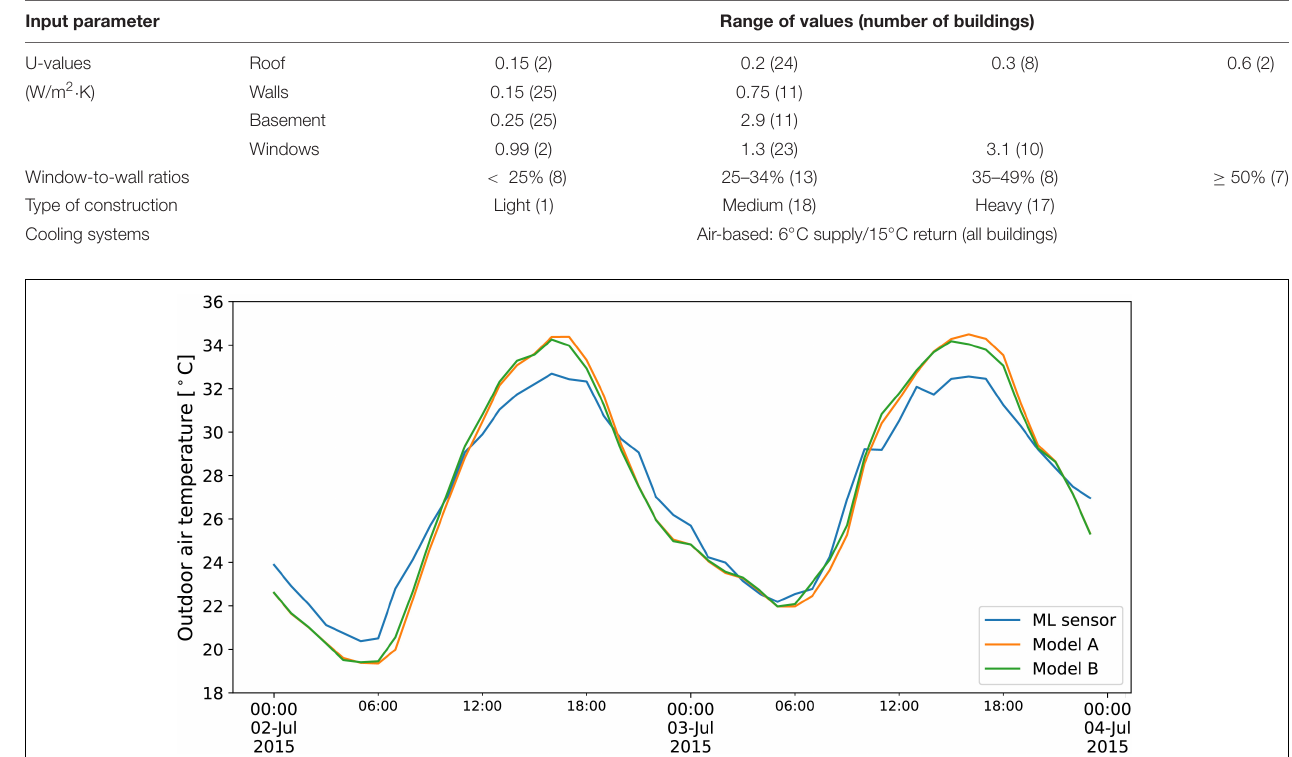
TABLE 5 | CEA model settings used in the case